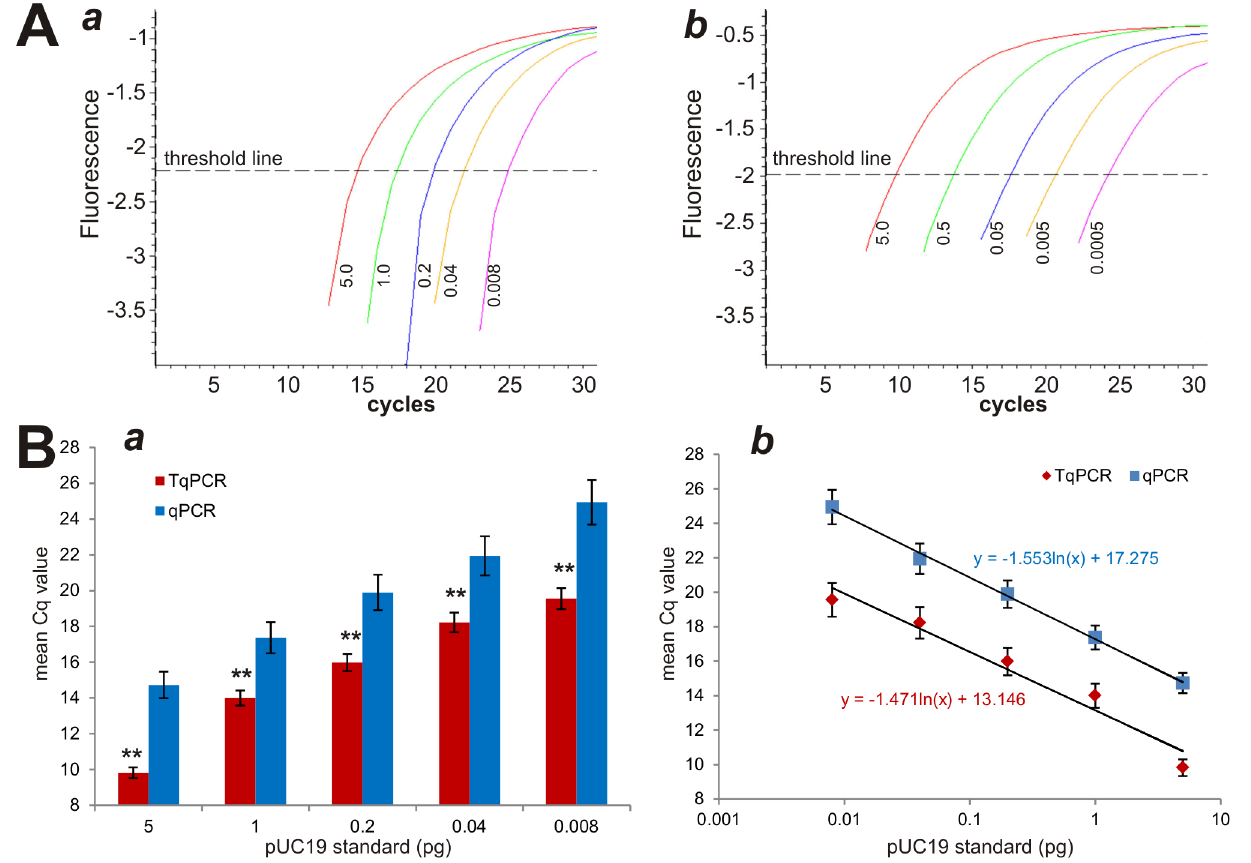
Fig 1. A comparison between conventional qPCR and touchdown qPCR (TqPCR) in quantitatively amplifying a target sequence in pUC19. (A) TqPCR expands the detection limit of DNA levels. PCR primers specific for pUC19 plasmid were used to amplify serially diluted pUC19 DNA, and the themocycling programs were carried out using a DNAEngine OPTICON II unit (Bio-Rad). PCR amplification curves (e.g., SYBR Green fluorescence history vs. cycle numbers) were plotted for conventional qPCR ( a ) and TqPCR ( b ) . (B) Cq value comparison between conventional qPCR and TqPCR reactions. Mean Cq values were obtained for both qPCR and TqPCR using the same dilution series of pUC19 DNA ( a ) . The standard curves were established with scatter plot ( b ) . Triplicate was performed for each assay condition. “ ** ” , indicating the Cq difference between qPCR and TqPCR groups is significant with p <